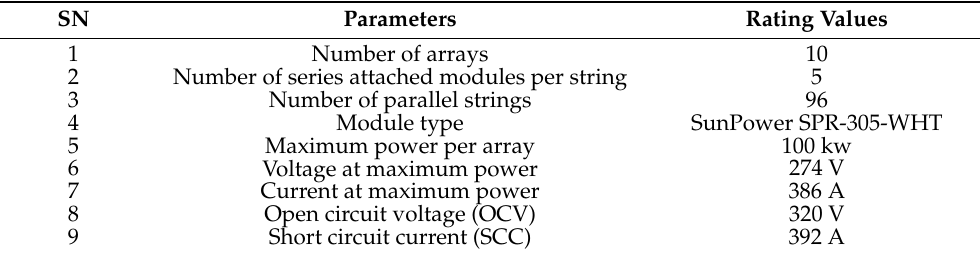
Table 1. Design specifications for PV